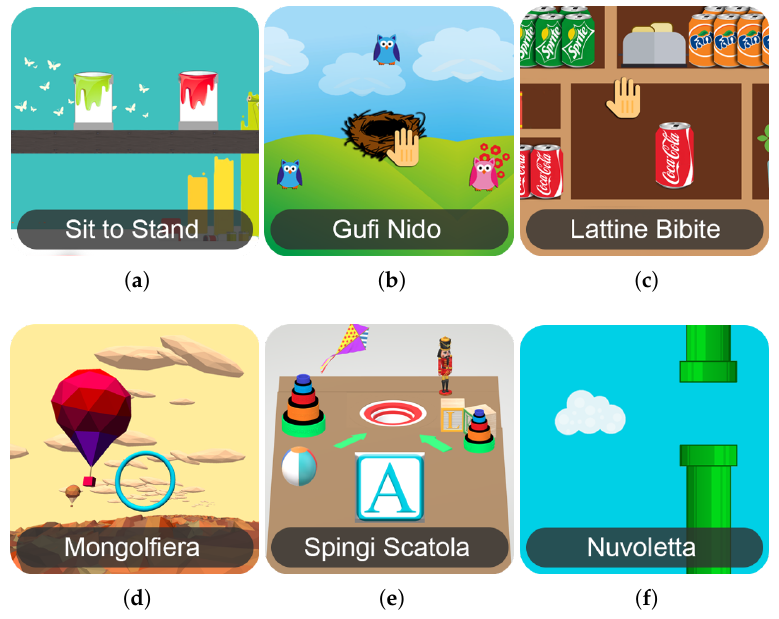
Figure 3. Thumbnails of Kinect exergames in current ReMoVES catalog. ( a ) Equilibrium Paint; ( b ) Owl Nest; ( c ) Shelf Cans; ( d ) Hot Air; ( e ) Push Box; ( f ) Flappy Cloud. For the sake of completeness, a brief description of the Kinect exergames